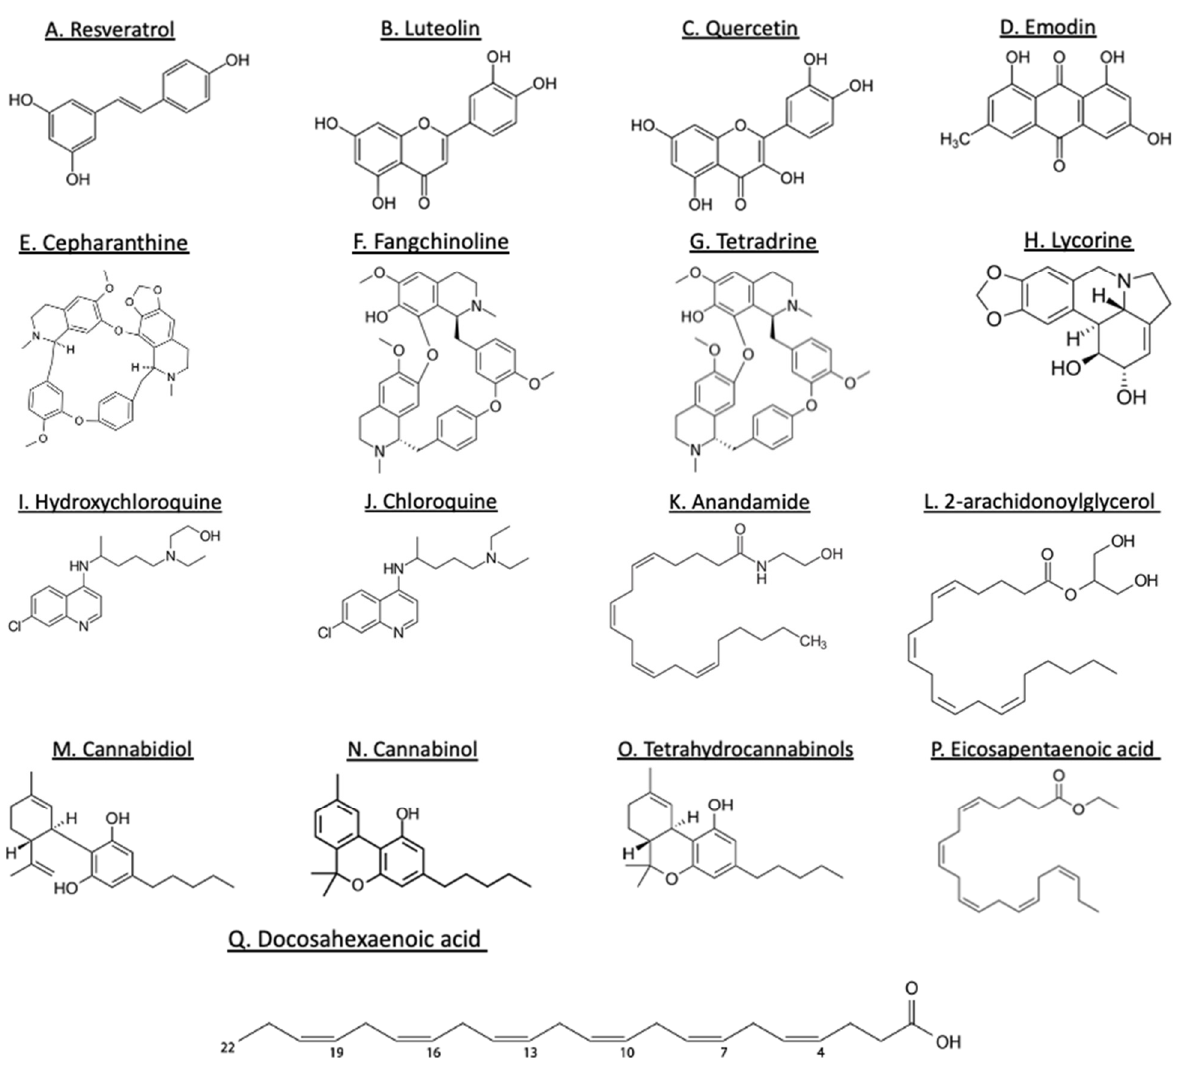
Figure 5. Structures of some plant-derived bioactive compounds. Polyphenols ( A – D ), alkaloids ( E – J ), cannabinoids ( K – O ), and lipids ( P – Q ).